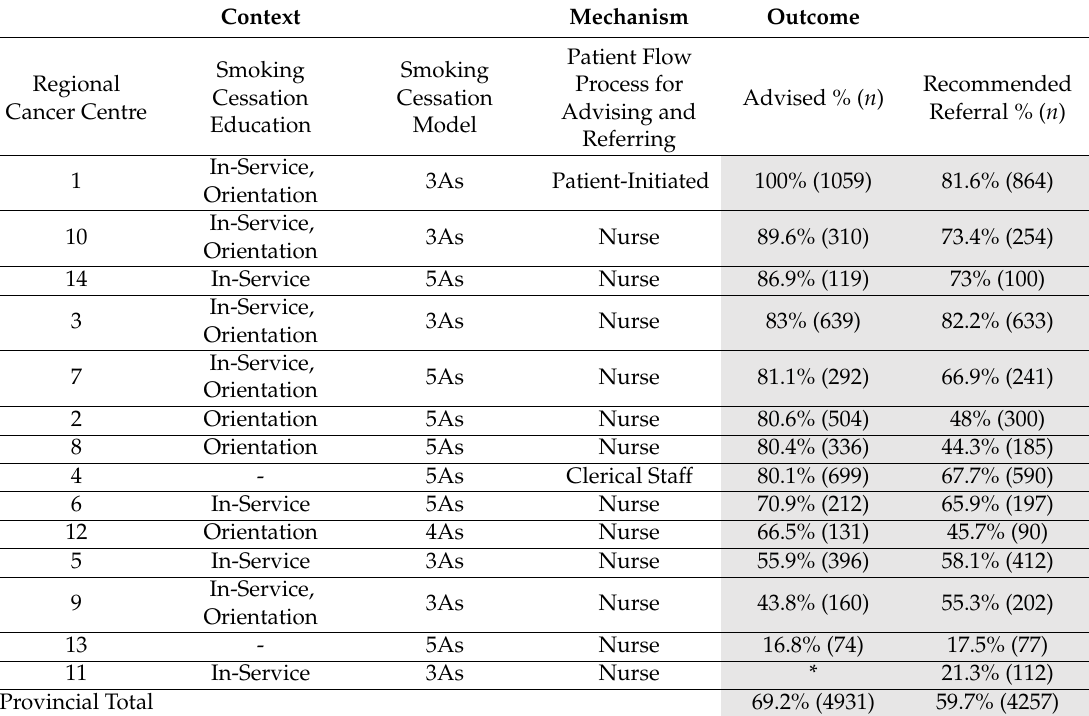
Table 3. Context and Mechanism variables that predict highest advise and recommended referral